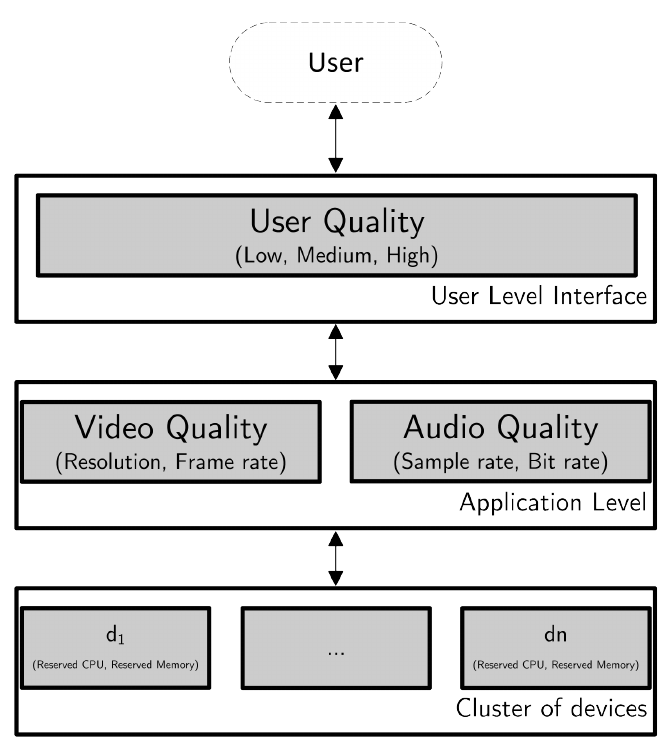
Figure 1. High-level view of the